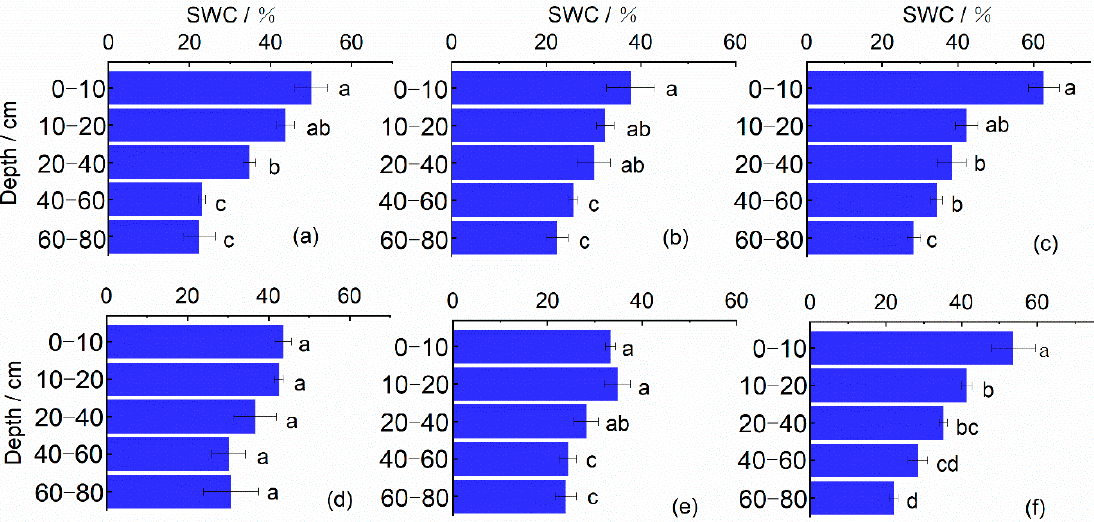
Figure 4. Monthly variation of water content during observation period. Mean and SD of three replicates are shown, and mean values with the same letter indicate no significant difference at p ≤ 0.05 level according to One-way ANOVA test. ( a – f ) respectively represent the chronological months from July to January of the following year.